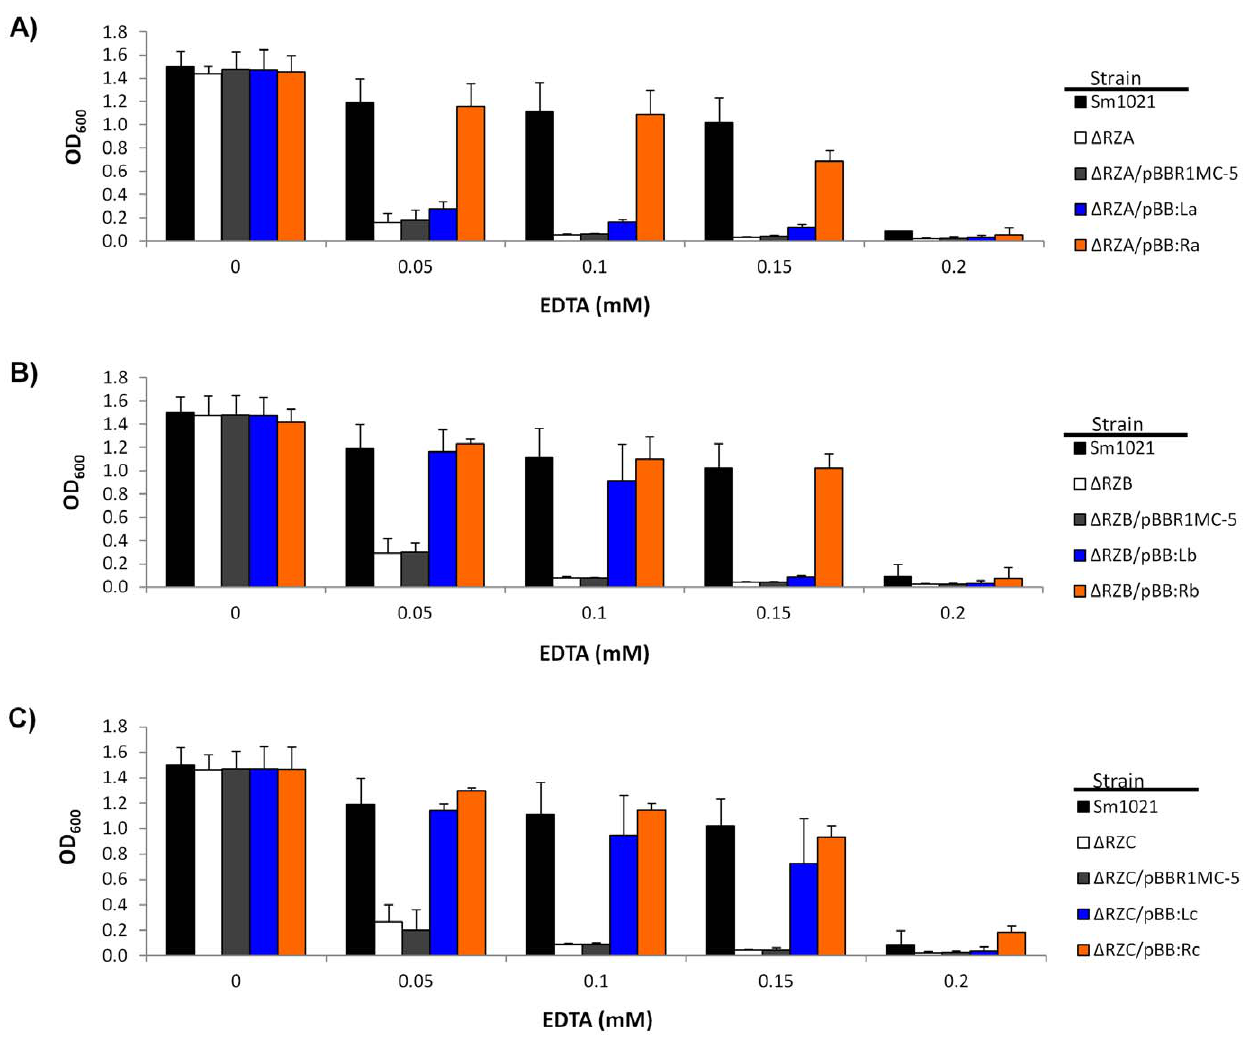
Figure 5. Growth of S.meliloti complemented strains. Deletion mutants of S. meliloti for A) znuA ( D RZA), B) znuB ( D RZB), or C) znuC ( D RZC) were complemented with the corresponding znu genes from either the wild-type S. meliloti (orange bars), or Ca. Liberibacter asiaticus (blue bars). As controls, the wild-type S. meliloti strain (black bars), the uncomplemented deletion strains (white bars), and those containing the vector control (grey bars) were also grown. Strains were grown in different concentrations of EDTA ranging from 0 to 0.2 mM (x-axis). The absorbance at 600 nm (OD 600 ) was measured at the time points indicated. Data shown is an average of three independent replicates with error bars representing the standard deviation.